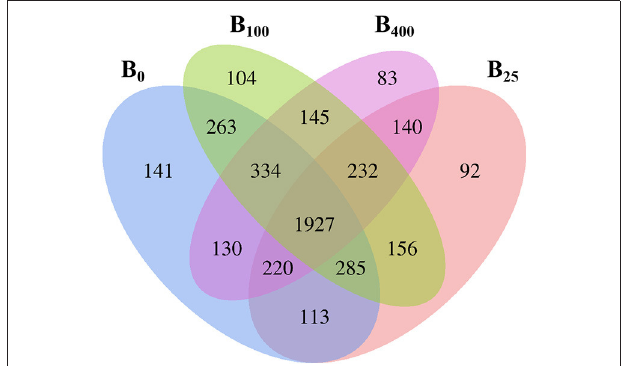
FIGURE 1 | Venn diagram analysis of proportion of the cecal microbes in different treatments.